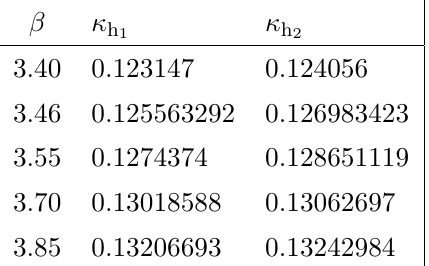
Table 2 . Hopping parameters of the partially quenched heavy valence quarks in the charm region serving to implicitly fix κ , provided by [59] in the context of determining leptonic decay constants c of D and D mesons [55, s